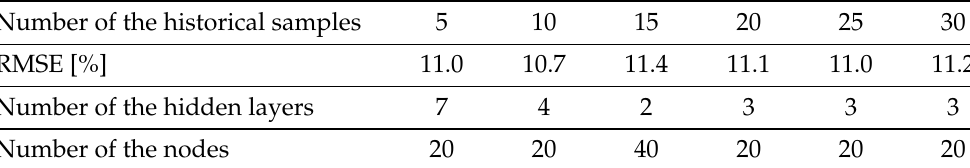
Table 7. Calculated the smallest RMSE for the selected numbers of the analyzed historical radio